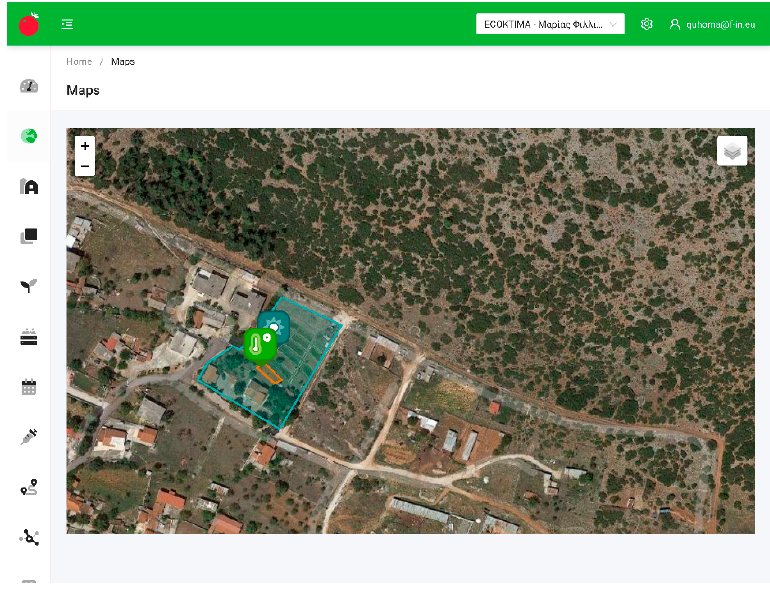
Figure 4. Implementation of the QUHOMA platform on a tunnel farm.